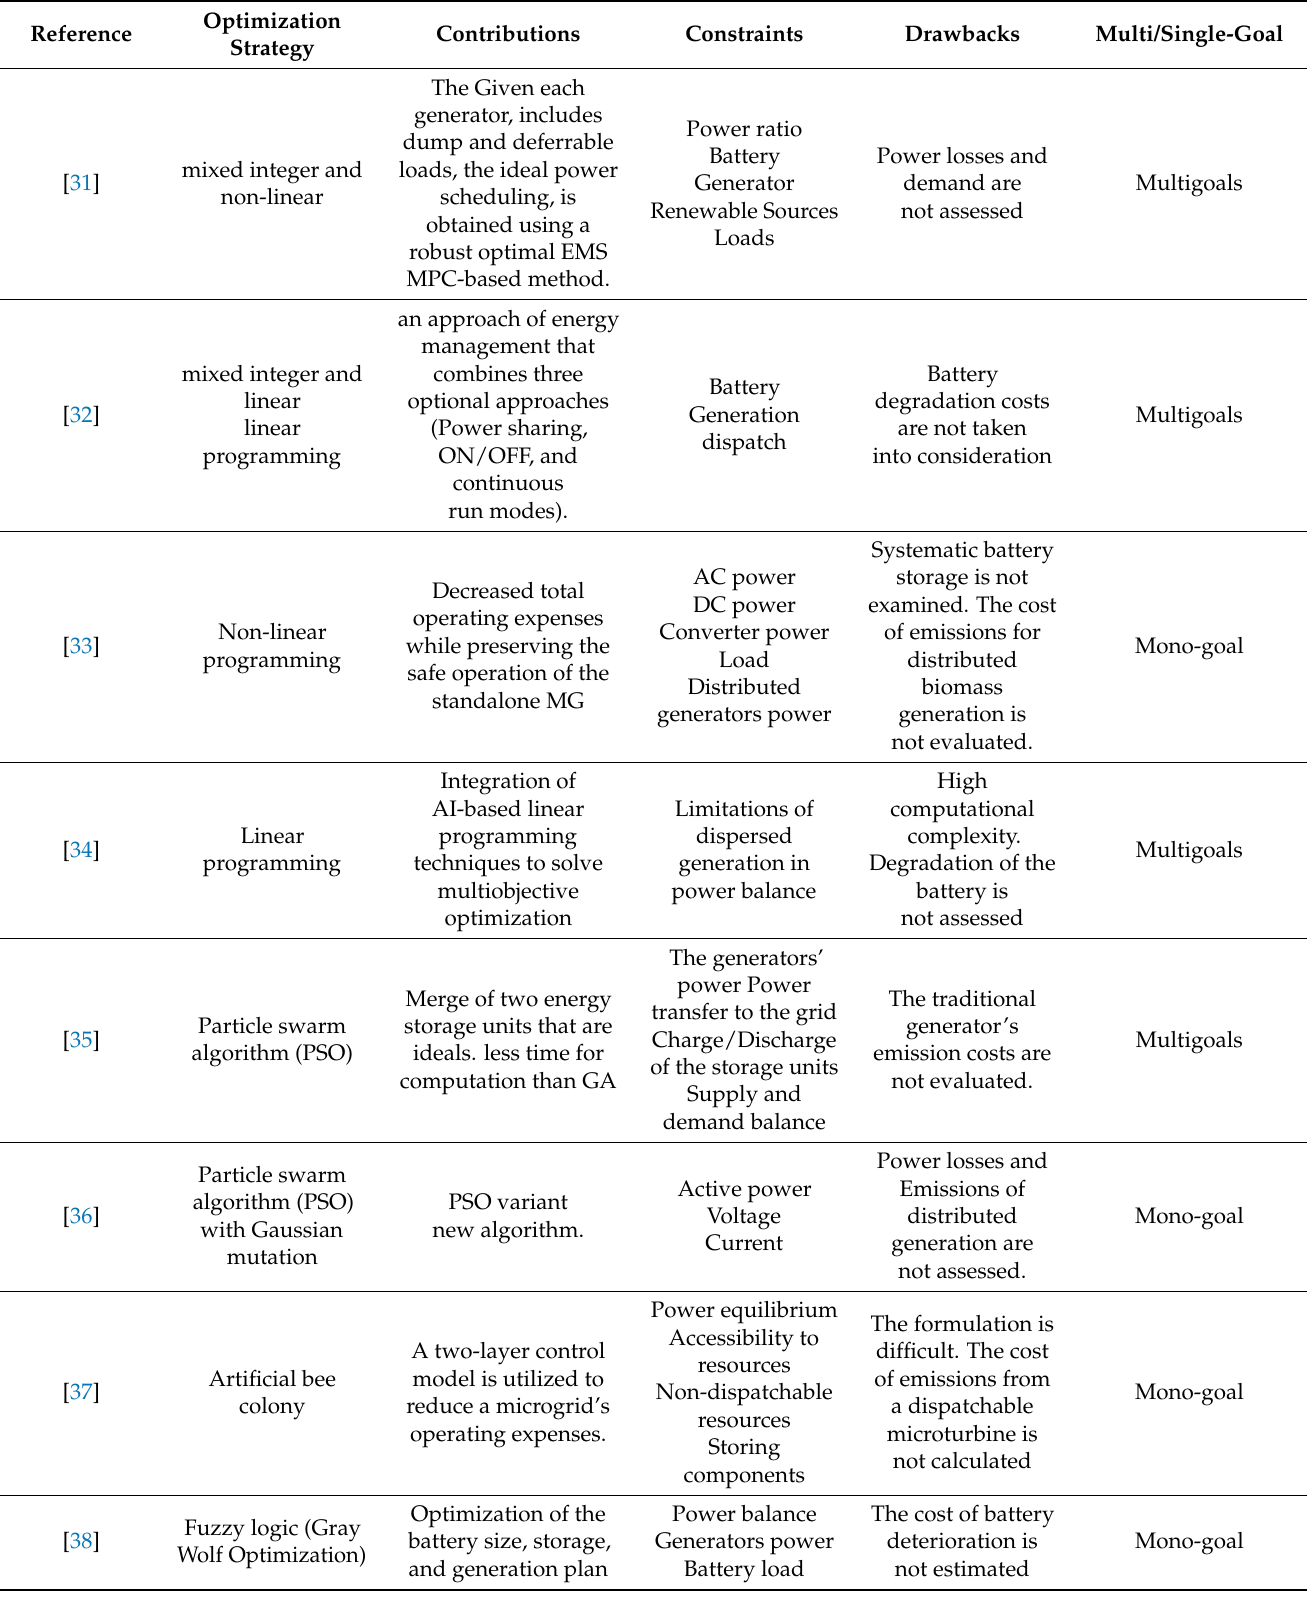
Table 2. An examination optimization of microgrid